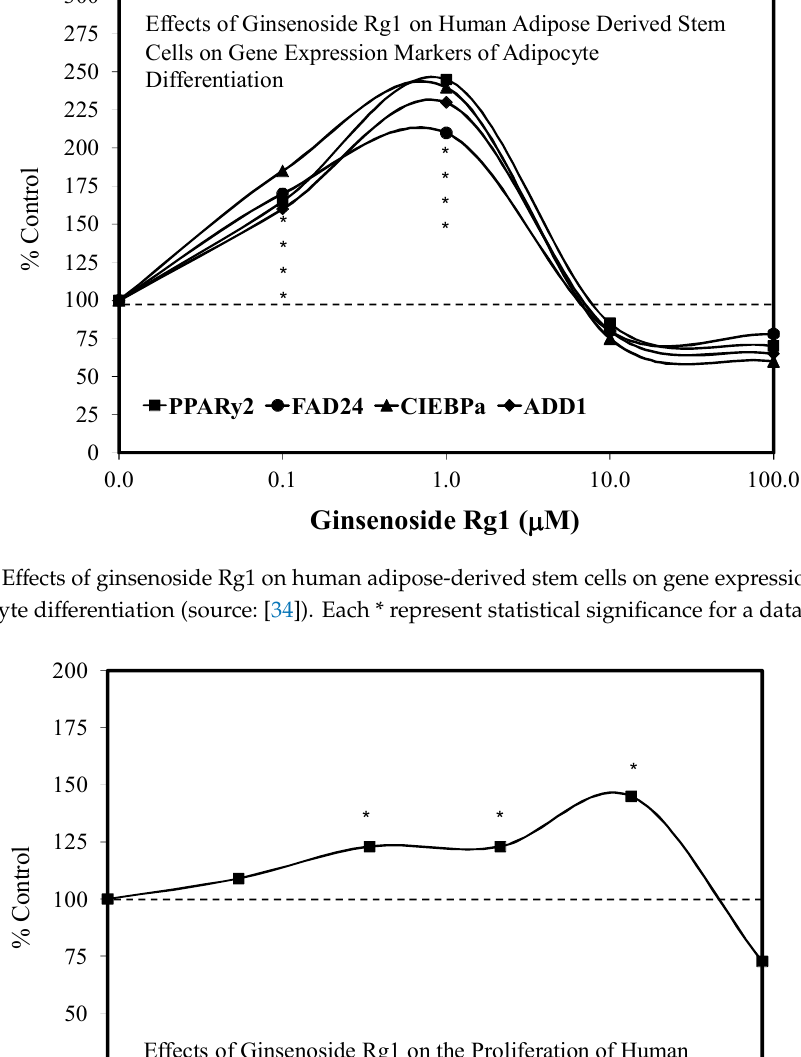
Figure 5. ( A ) Effects of ginsenoside Rg1 on human adipose-derived stem cells on paracrine activity and angiogenosis-related gene expression after 7 days (source: [34]). ( B ) Effects of ginsenoside Rg1 on human adipose-derived stem cells on paracrine activity and angiogenosis-related gene expression after 7 days (source: [34]). Each * represent statistical significance for a data point.